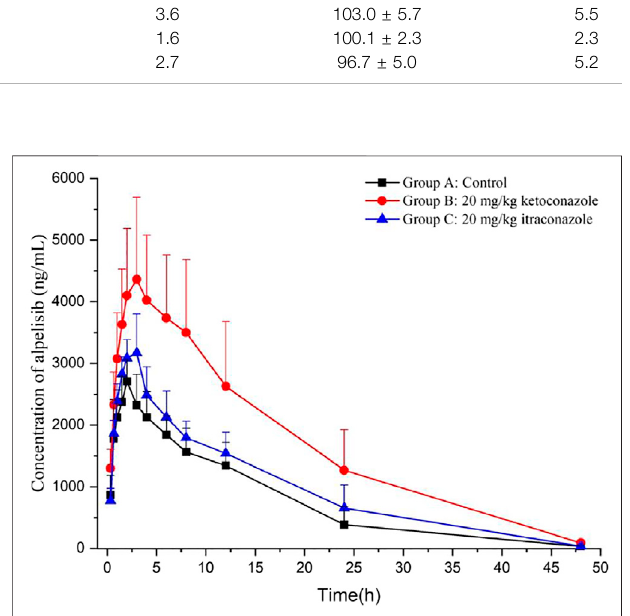
FIGURE 3 | Mean plasma concentration-time curves of alpelisib in differenttreatmentgroupsofrats:groupA,thecontrolgroup(0.5%CMC-Na); group B, a single-dose administration of ketoconazole (20 mg/kg); group C, a single-dose administration of itraconazole (20 mg/kg). ( n (cid:1)